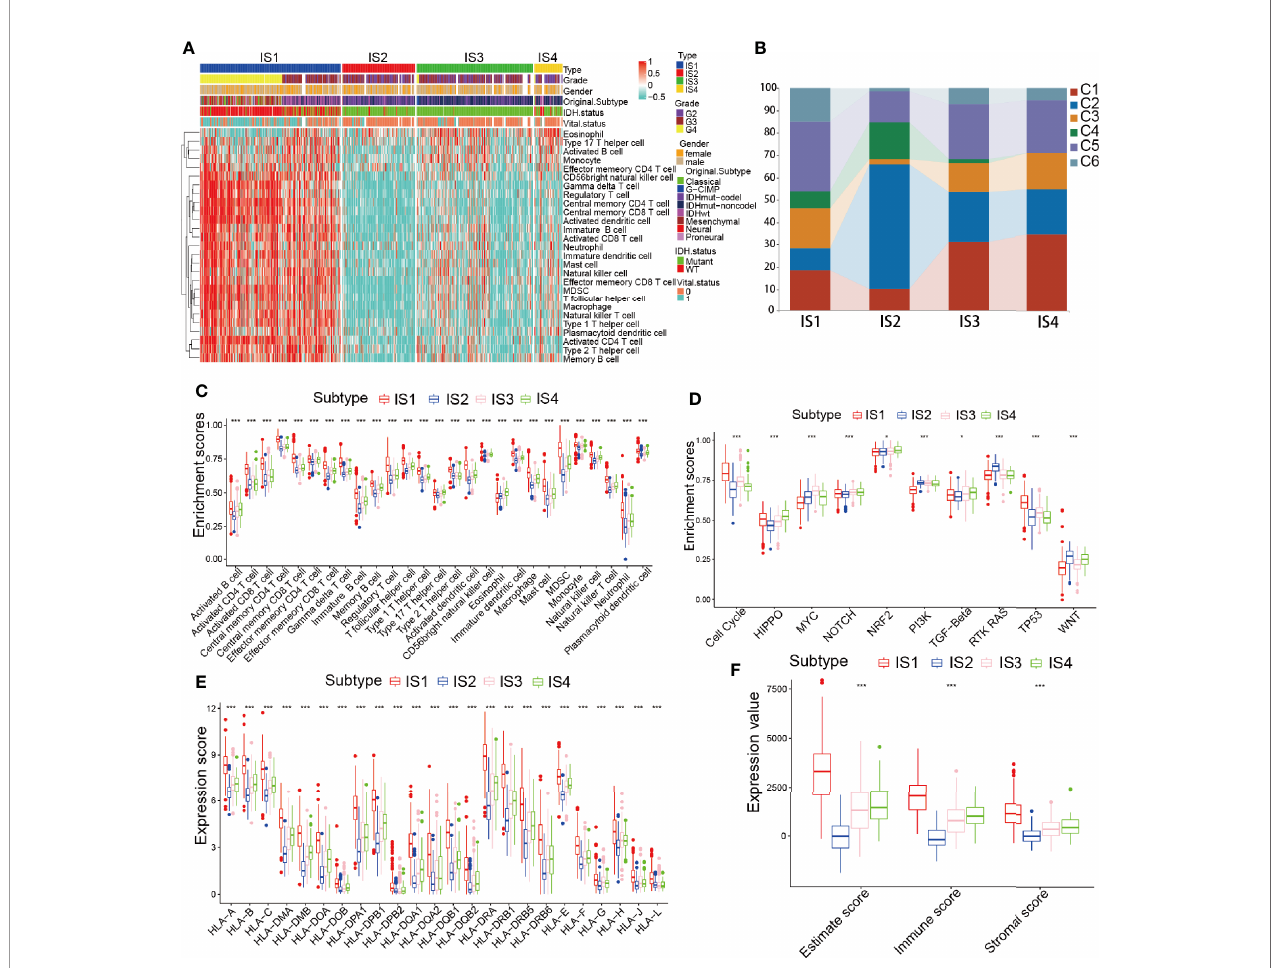
FIGURE 6 | Immune types of immune cell in fi ltration in the TCGA cohort. (A) Heatmap analysis of the distinct enrichment scores of 28 immune cells among the glioma immune subtypes. (B) Distribution of IS1-IS4 between pan-cancer immune types (C1-C6) in the TCGA cohort. (C – F) Distribution of 28 immune cells (C) , 10 oncogenic pathways (D) , human leukocyte antigen (HLA) molecules (E) , and ESTIMATEScore (F) across the 4 immune types. *p < 0.05 and ***p <